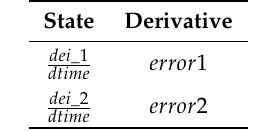
Table 7. ODE page of classical control (MIMO